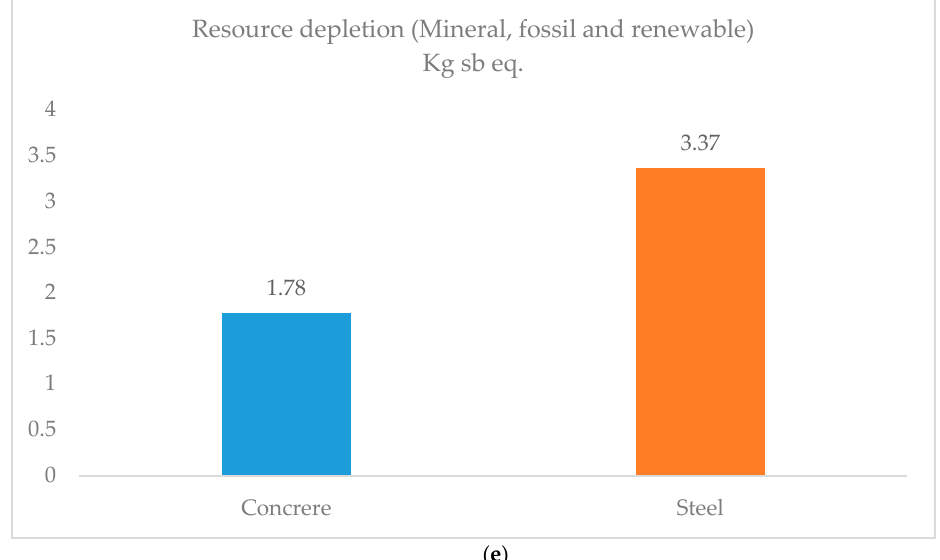
Figure 6. LCIA results for concrete and steel buildings in eleven scenarios: ( a ) GWP and Climate change; ( b ) Water, AP and EP; ( c ) Ecotoxity, Resources and Acidification Air; ( d ) Human toxicity; ( e ) Mineral, fossil and renewable